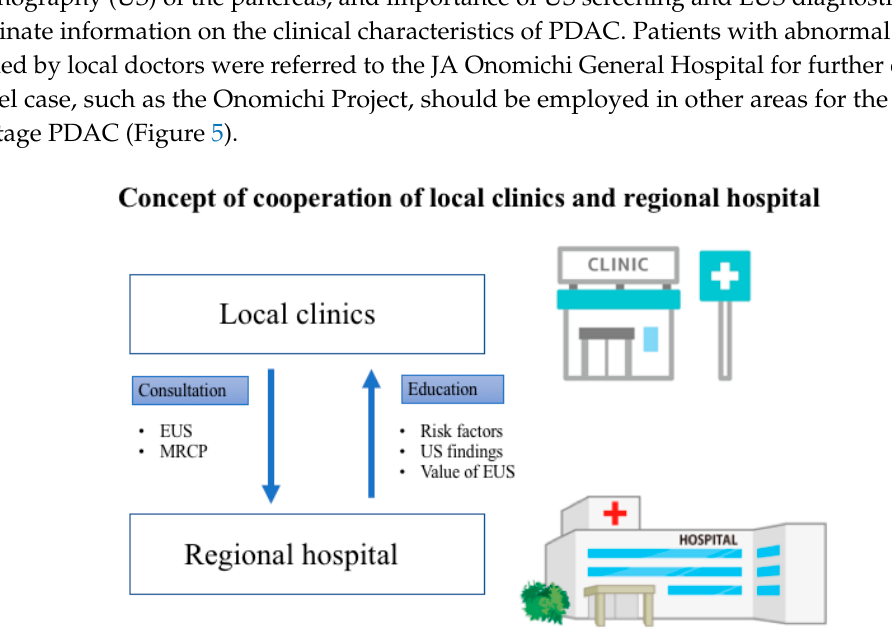
Figure 5. Concept of cooperation of local clinics and regional hospitals. Networks between local clinics and regional hospitals should be established to detect early-stage pancreatic cancer. EUS, endoscopic ultrasonography; MRCP, magnetic resonance cholangiopancreatography; US, ultrasonography.